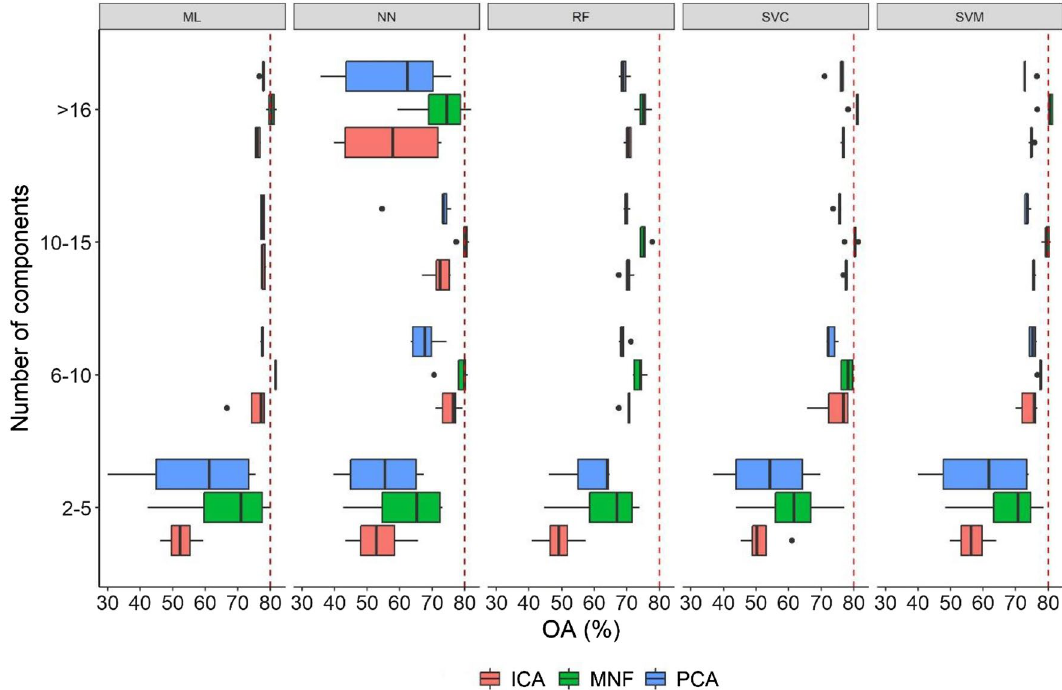
Figure 3. Overall accuracies (OA) of 300 models by the number of components, classification algorithms and dimension reduction types. Dashed line: 80% accuracy benchmark, Ord dimension reduction type, MNF Minimum Noise Fraction, PCA Principal Component Analysis, ICA Independent Component Analysis, ML Maximum Likelihood, SVM Support Vector Machine, SVC Linear type of SVM, FR Random Forest, NN Neural